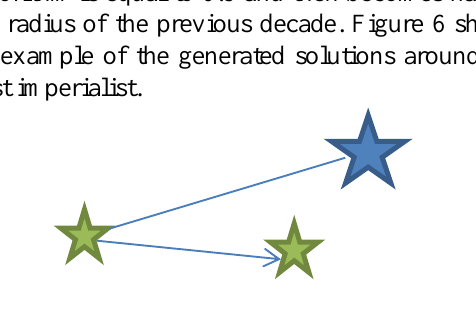
Figure 5. The imperialists’ movement.